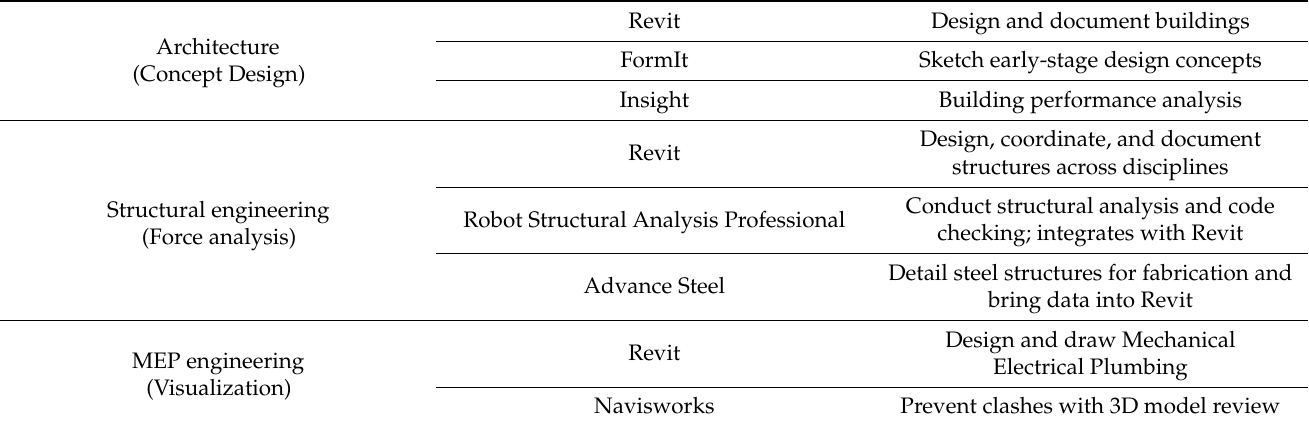
Table 1. Software property